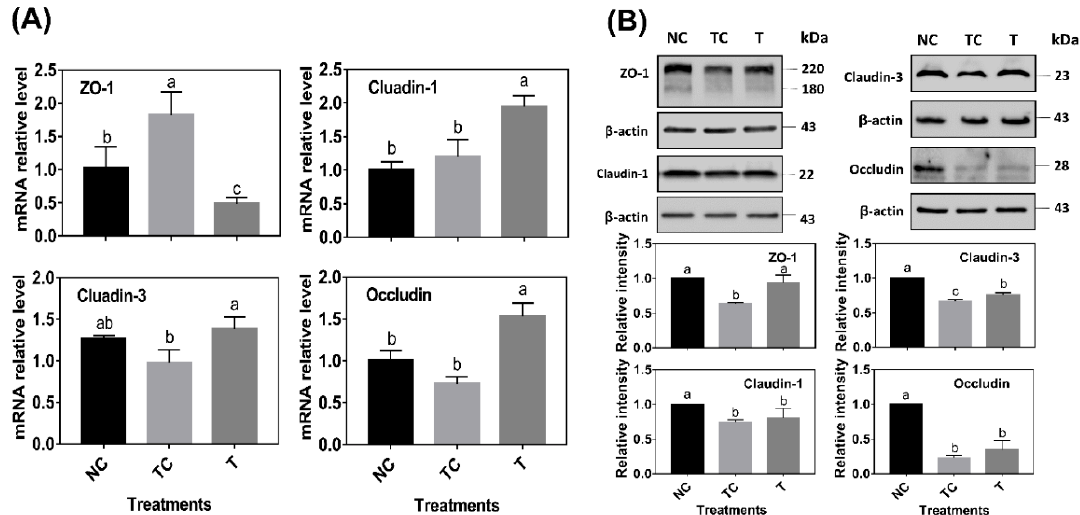
Figure 6. The effect of red-osier dogwood extracts (RDE) on the tight junction mRNA abundance ( A ) and protein abundance ( B ) of Caco-2 cells after H 2 O 2 treatment. NC indicates negative control: cells were cultured with a medium without H 2 O 2 and RDE for 27 h (3 h + 24 h). TC means treatment control: cells were cultured with a medium containing 1 mM of H 2 O 2 for 3 h, and then treated with a medium for 24 h. T indicates RDE treatment: cells were cultured with a medium containing 1 mM of H 2 O 2 for 3 h, and then treated with a medium containing 100 µ g / mL of RDE for 24 h. The data were presented as mean ± SD, n = 3. Different lower case letters indicate a significant difference at P < 0.05. ZO-1: zonula occludens-1. The black bar, gray bar, and light black bar indicated the treatments NC, TC, and T, respectively.